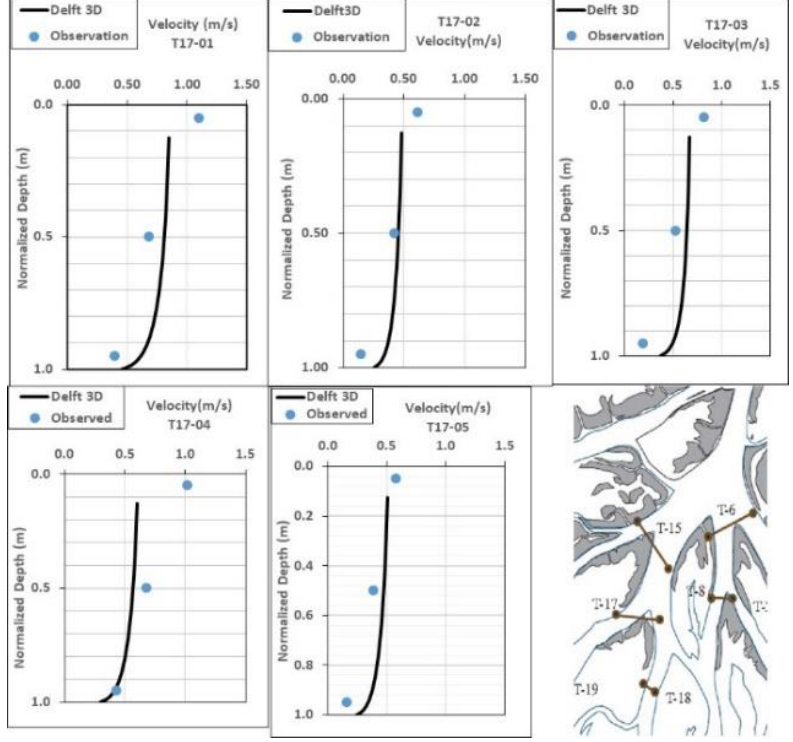
Figure 4. Calibration results showing comparison of modeled and observed streamwise velocities at Gadwall Pass.